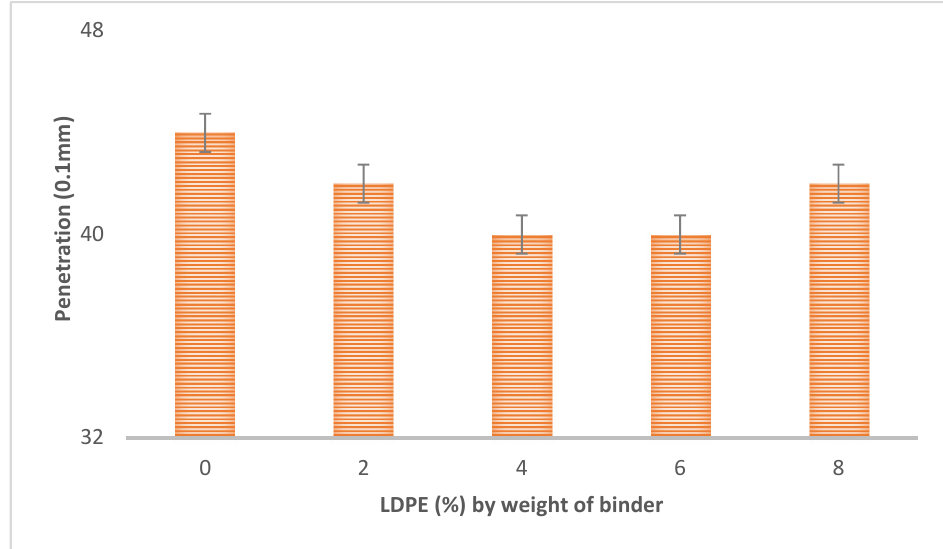
Figure 5. Results for the penetration of unaged LDPE-modified bitumen.